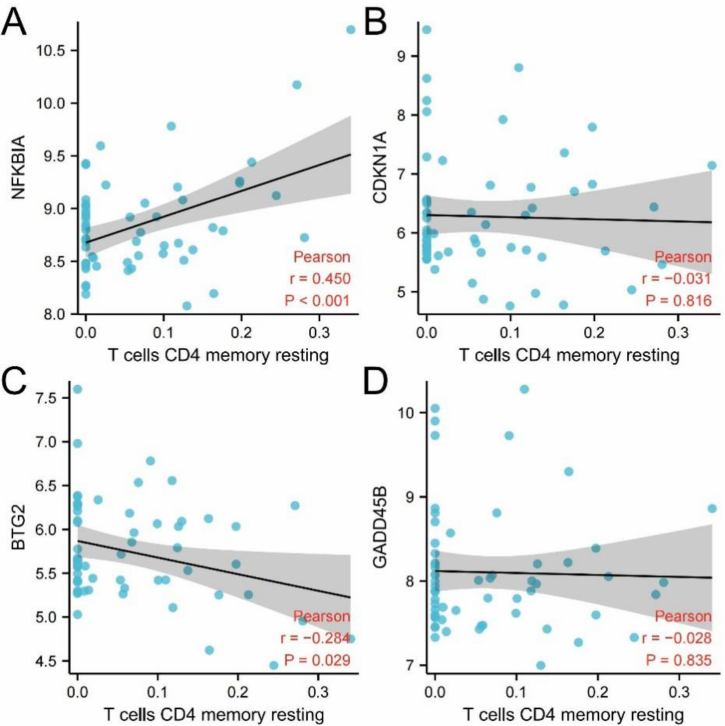
Figure 12. Correlation analysis between hub genes and resting memory CD4 T cells. ( A ) NFKBIA and resting memory CD4 T cells; ( B ) CDKN1A and resting memory CD4 T cells; ( C ) BTG2 and resting memory CD4 T cells; ( D ) GADD45B and resting memory CD4 T